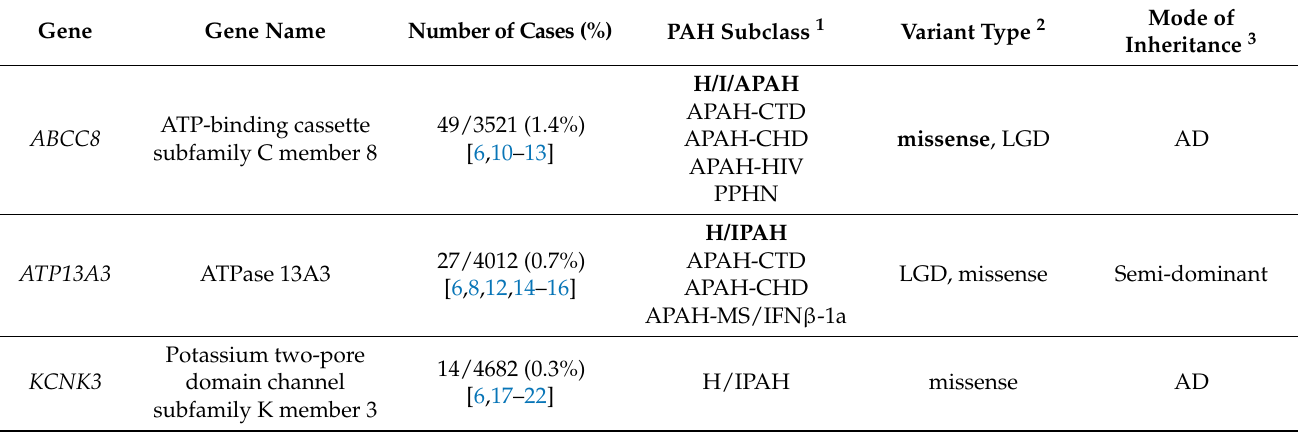
Table 1. PAH causal channelopathy genes and associated variant allele frequencies/characteristics across multiple